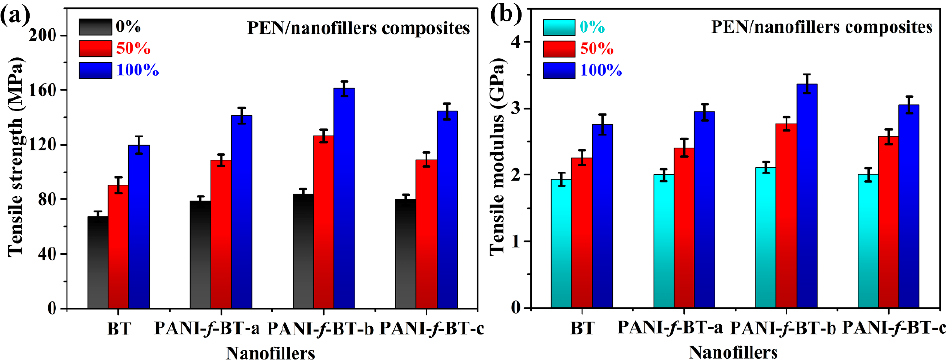
Figure 8. The mechanical properties of nanocomposite films at different stretching ratios: ( a ) tensile strength and ( b ) tensile modulus.